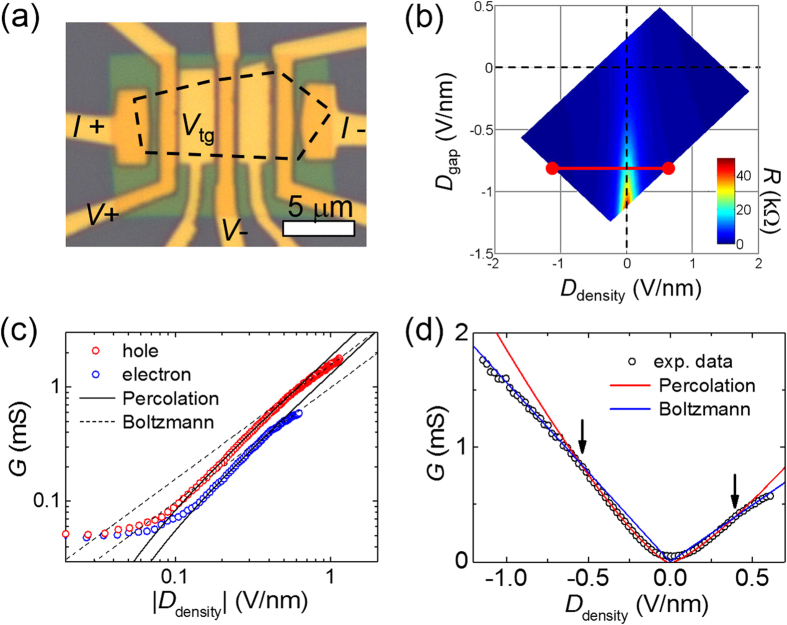
Percolation transport behavior in the gapped bilayer graphene.(a) Optical image of the dual-gated bilayer graphene device with measurement configuration. (b) Resistance map as a function of Ddensity and Dgap measured at 4.2 K. (c) Log-log plot of conductance as a function of |Ddensity| in the hole side (red symbols) and electron side (blue symbols). Best fits to the percolation behavior (solid lines) in the range of 0.1 V/nm < |Ddensity| < 0.5 V/nm gives the critical exponent of δh = 1.25 ± 0.02 and the critical carrier density of  cm−2 in the hole side, and δe = 1.25 ± 0.05 and  cm−2 in the electron side. Dotted lines represent the Boltzmann transport behavior for highly doped state (|Ddensity| > 0.5 V/nm). (d) Linear plot of the same data and the fitting lines of (c). Arrows indicate the crossover between Boltzmann and percolation transport regimes.